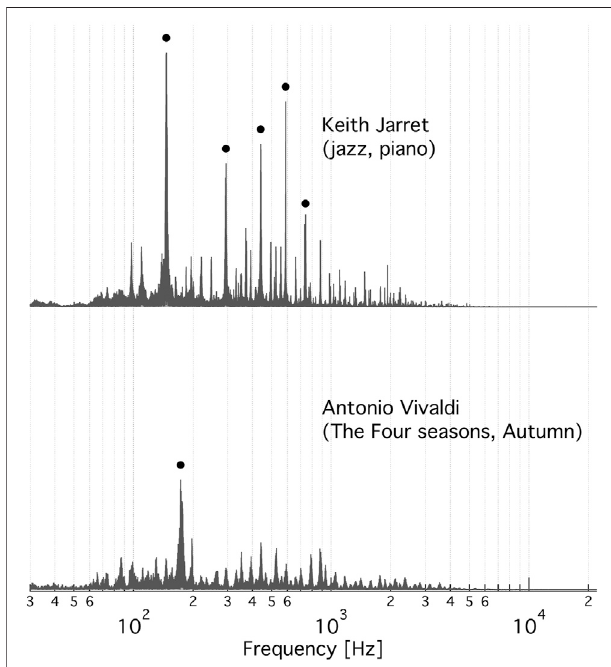
FIGURE 3 | The FFT spectrum of the music clip that most stimulates (top) and most inhibits (bottom) the speci fi c activity of V-ATPase. Top: An excerpt from Keith Jarret ’ s Köln concert (jazz, piano). The black circles indicatethe fi vehighestpeaksat146.7 ± 1.9Hz,293.4 ± 3.3Hz,440.9 ± 2.9 Hz, 587.9 ± 1.9 Hz, and 742.5 ± 1.2 Hz. Bottom: An excerpt from the Autumn of Antonio Vivaldi ’ s Four Seasons. The black circle marks the peak at 174.9 ± 5.3 Hz.The ± frequencyintervalsindicatetheline-widthofaGaussian function fi tted to the respective peak.